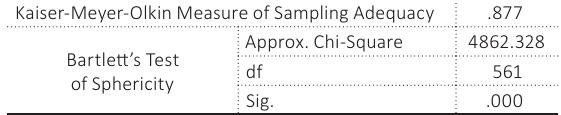
Table 2. KMO and Bartlett’s test